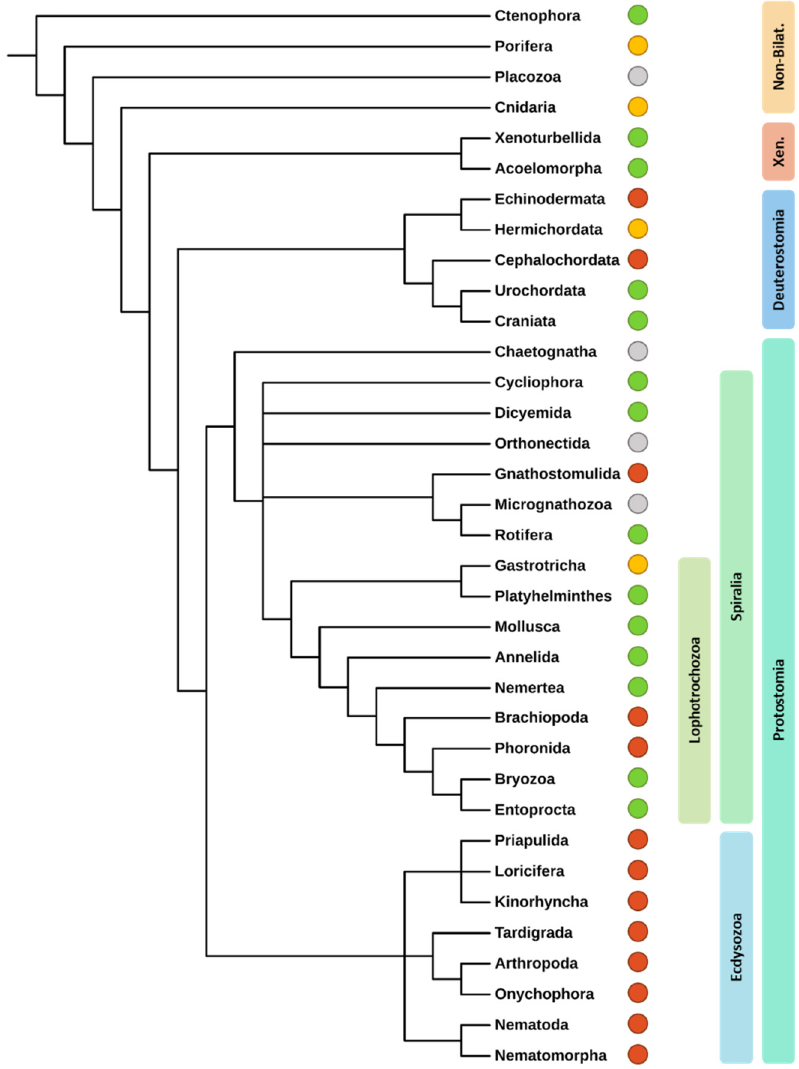
Figure 1. Distribution of MCCs in different metazoan clades. A green circle indicates the presence of MCCs, a red circle indicates their absence. A yellow circle indicates the existence of both multiciliated species and strictly monociliated species in the same branch. Gray circles indicate a lack of information regarding multiciliation. Xen.: xenacoelomorpha; Non-Bilat: non-bilaterian. Phylogeny based on the results of Giribet [12].